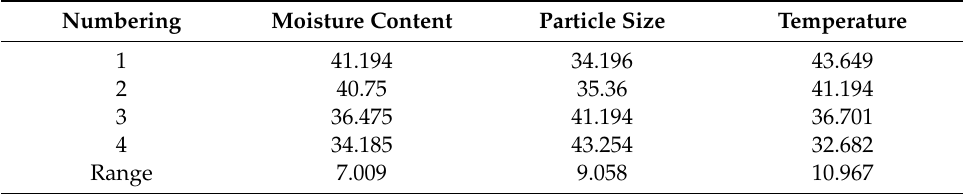
Table 3. Extremum di ff erence analysis of methane adsorption principle of #1890 coal sample.